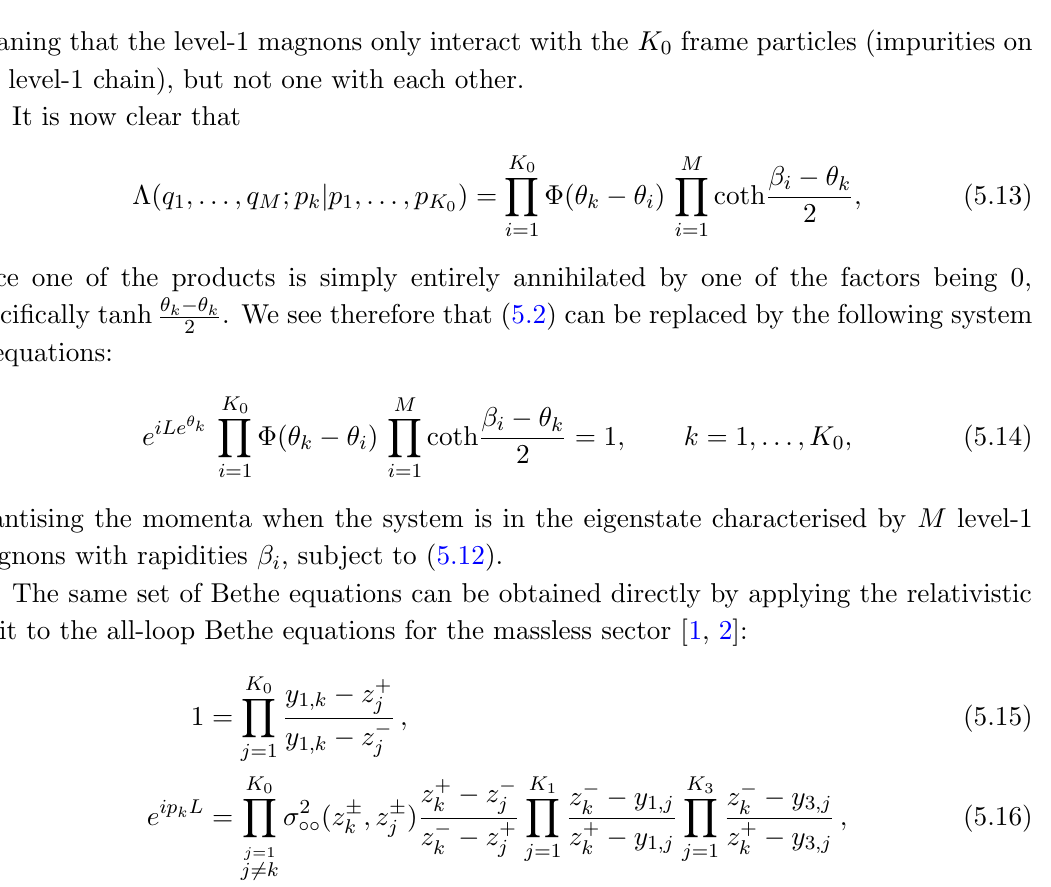
Figure 1 . The transfer matrix is obtained by identifying a = b in the monodromy matrix, and summing over P . The indices a and b are in the auxiliary 0-th space, while the indices c i and d i a pertain to the chain of frame particles (often referred to as the quantum space